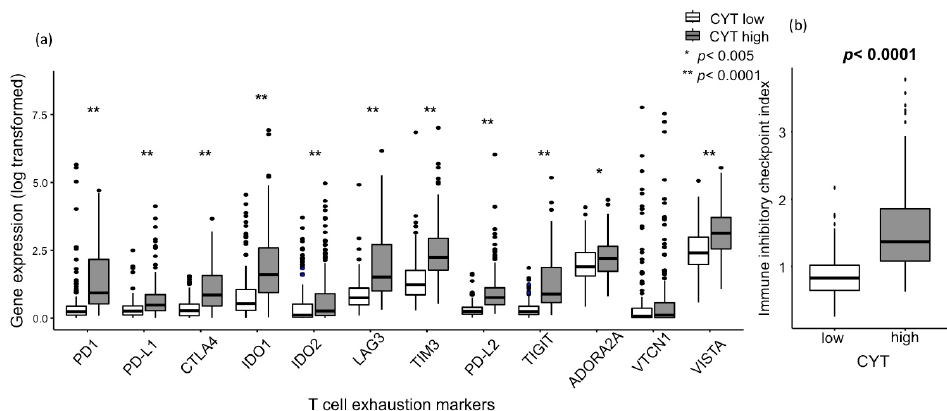
Figure 4. Association between the CYT and gene expression of regulatory T-cell markers. ( a ) Association between the CYT and major T cell exhaustion marker gene expressions, including PD-1 ( p < 0.0001), PD-L1 ( p < 0.0001), CTLA4 ( p < 0.0001), IDO1 ( p < 0.0001), IDO2 ( p < 0.0001), LAG3 ( p <